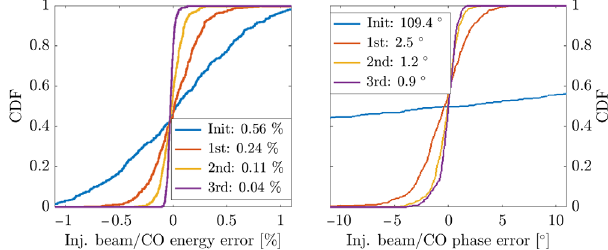
seed).FIG. 12. Results of the rf commissioning procedure. Shown is the difference between the closed orbit energy (left) and phase (right) with respect to the injected beam, both initially (blue) and after each of the three iterations. The rms values are shown in the